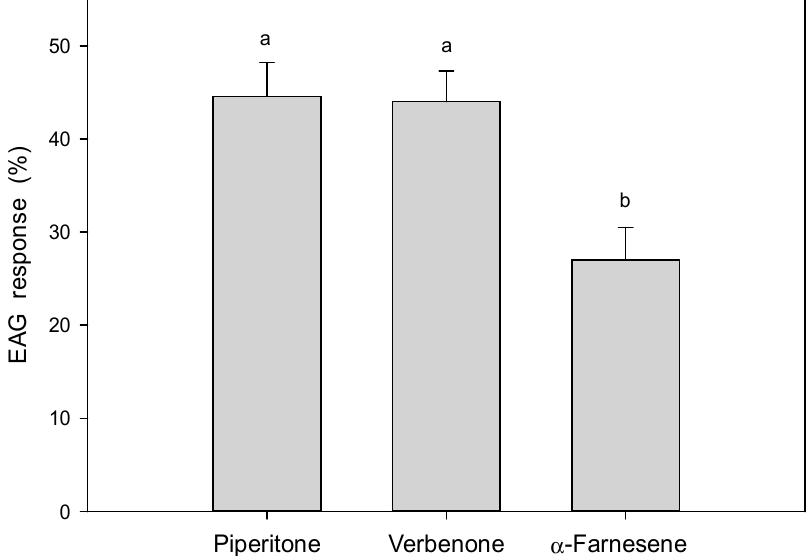
Figure 5. Mean ( ± SE) electroantennogram responses of female Euwallacea perbrevis to volatiles (fixed 1 mL doses of saturated vapor) emitted from bubble formulations of scolytine repellents. EAG responses were normalized (expressed as percentages relative to an ethanol standard [24]). Bars topped with the same letter are not significantly different (Tukey’s HSD mean separation, p < 0.05).